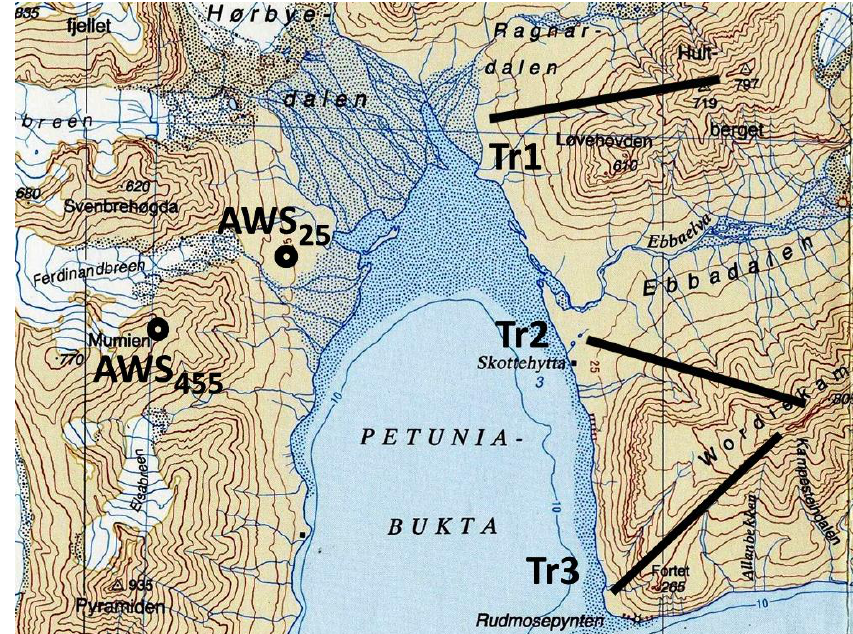
- Figure 1. Location of the three transects investigated (Tr1–Tr3) and automated weather stations (AWSs) in Petunia Bay